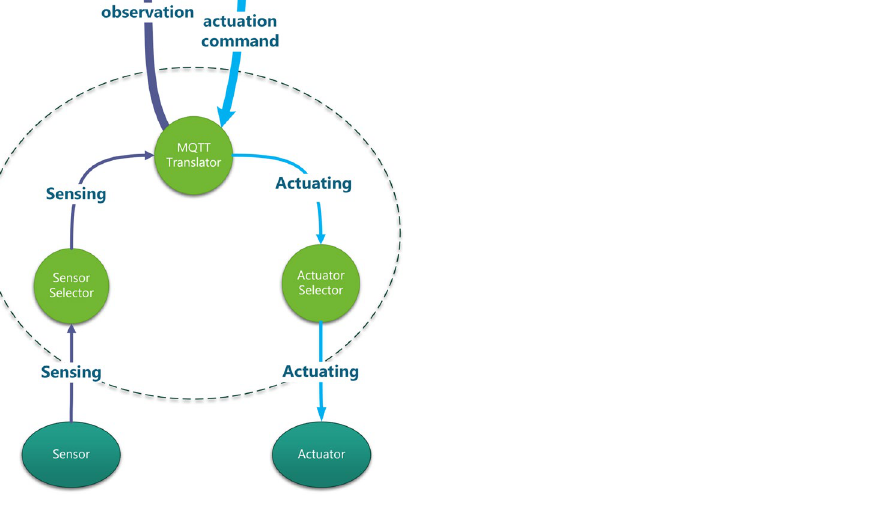
Figure 5. Gateway design with all its components and types of internal messages among its